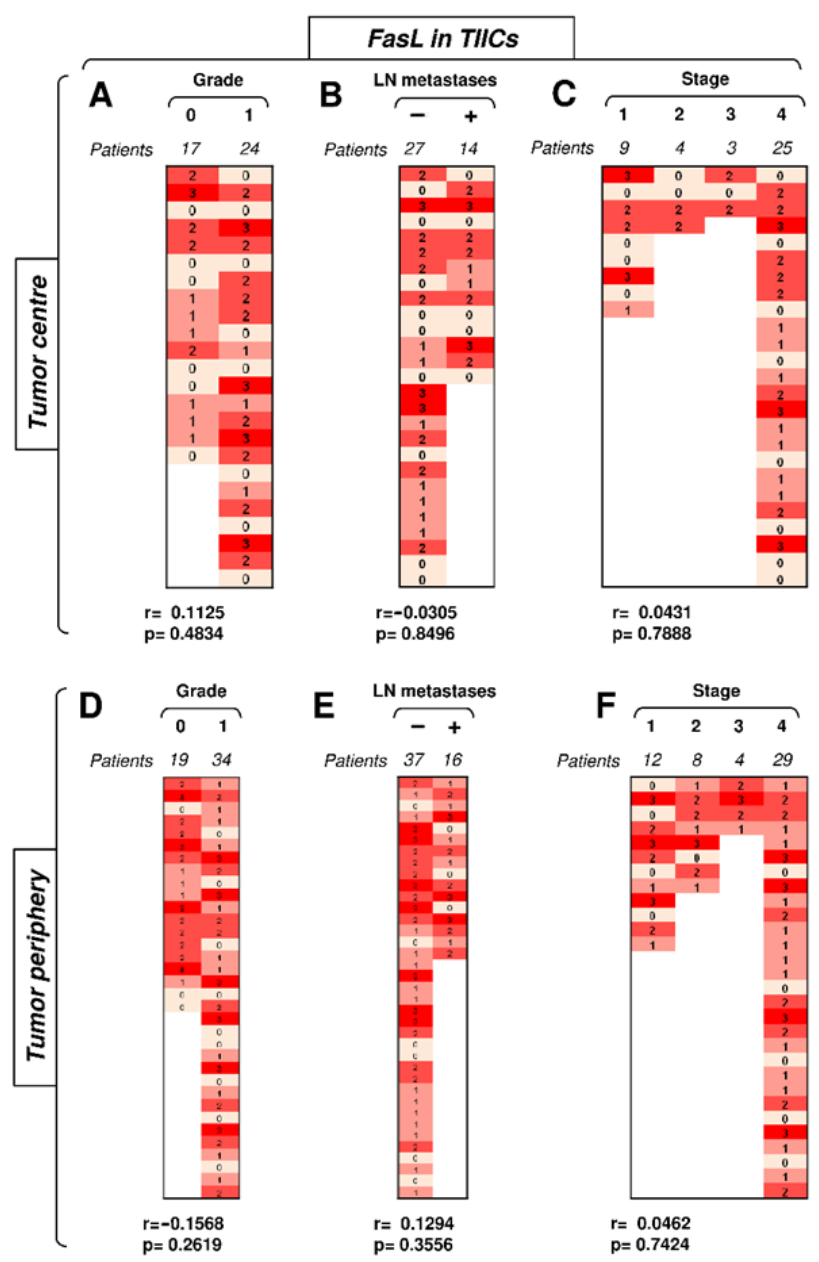
Figure 5. The expression of FasL in TIICs does not correlate with disease severity. ( A ) The cohort of 41 SGC patients was stratified into 2 groups according to tumor grade (grade 0 and grade 1), and the Spearman correlation ( r ) according to the expression of FasL in TIICs in the tumor center was determined. The expression analyses were performed according to the scoring system described in the Materials and Methods section. The data are presented as a heat map with the scores, and the calculated p < 0.05 (red) was considered significant. ( B ) The patient cohort in ( A ) was stratified into 2 groups according to the absence ( − ) or presence (+) of lymph node (LN) metastases, and the Spearman correlation ( r ) was determined as in ( A ). ( C ) The patient cohort in ( A ) was stratified into 4 groups according to the primary tumor stage, and the Spearman correlation (r) was determined as in ( A ). ( D – F ) The cohort of 53 SGC patients was stratified into groups as in ( A – C ), and the Spearman correlation ( r ) according to the expression of FasL in TIICs in the tumor periphery was